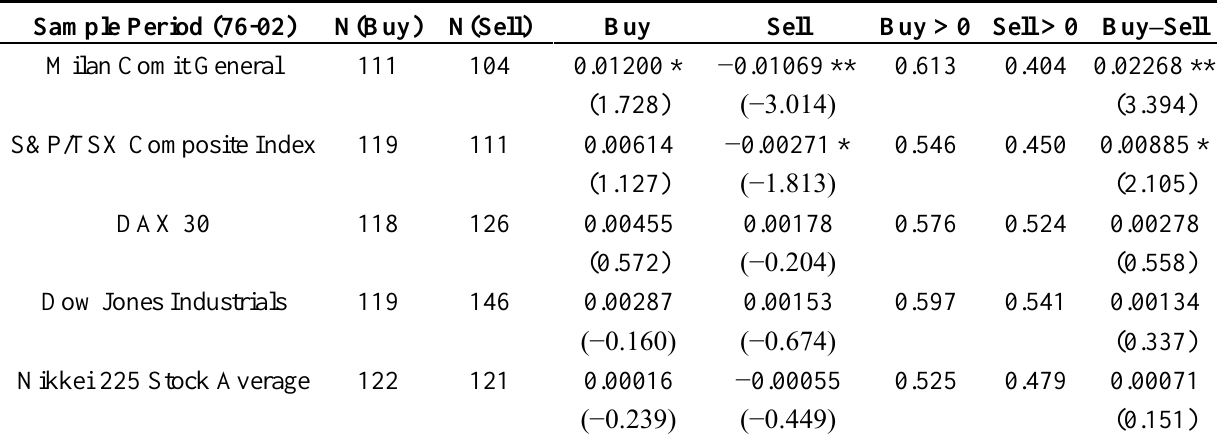
Table 3C. Average ten-day returns from RSI (21, 50).